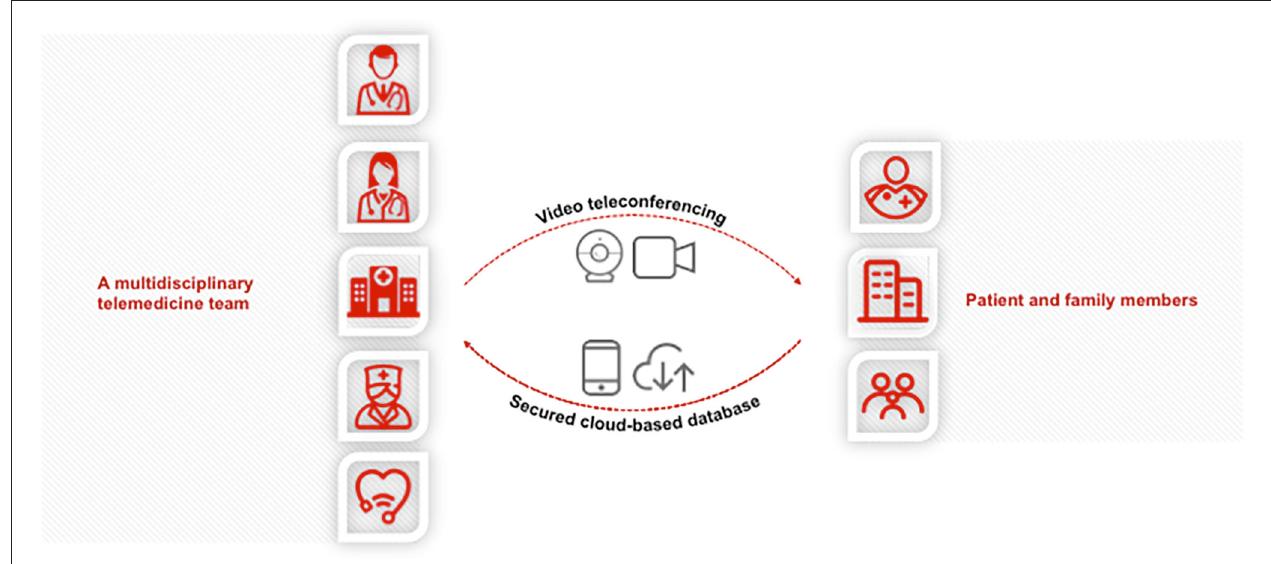
FIGURE 1 | Schema of multidisciplinary care for the Tourette syndrome (TS) via telemedicine. Video telemedicine can be used to provide comprehensive care and support for TS patients and their families/caretakers in a timely and easily accessible fashion while ensuring patient privacy and HIPAA compliance. Neurologists and psychiatrists can evaluate the patients and offer management plans and education remotely. Behavioral therapists and psychologists can provide the Comprehensive Behavioral Intervention for Tics (CBIT), other psychosocial and behavioral interventions, and psychoeducation via telemedicine. Additional specialty service and social work needs can also be accommodated via telemedicine as appropriate. In summary, telemedicine promises to be a revolutionary approach to improve access to care for patients with TS, especially those living in more rural areas. Its feasibility, satisfaction, clinical effects, and cost-effectiveness should be assessed by further research. Potential limitations such as technological issues, reimbursement, and licensure should be addressed as well.